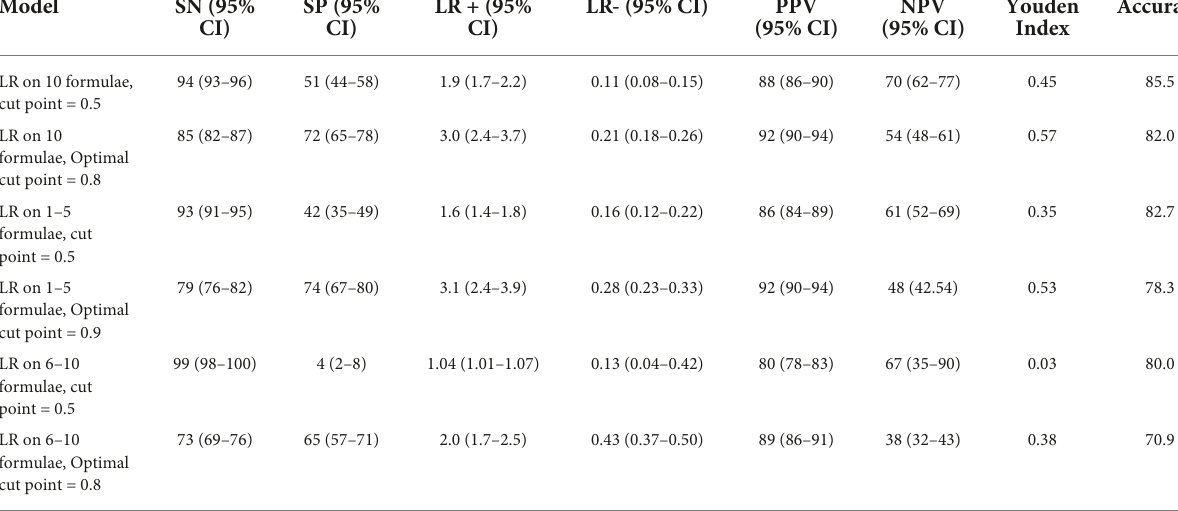
TABLE 5 Diagnostic indices after multiple logistic regression model based on validation data